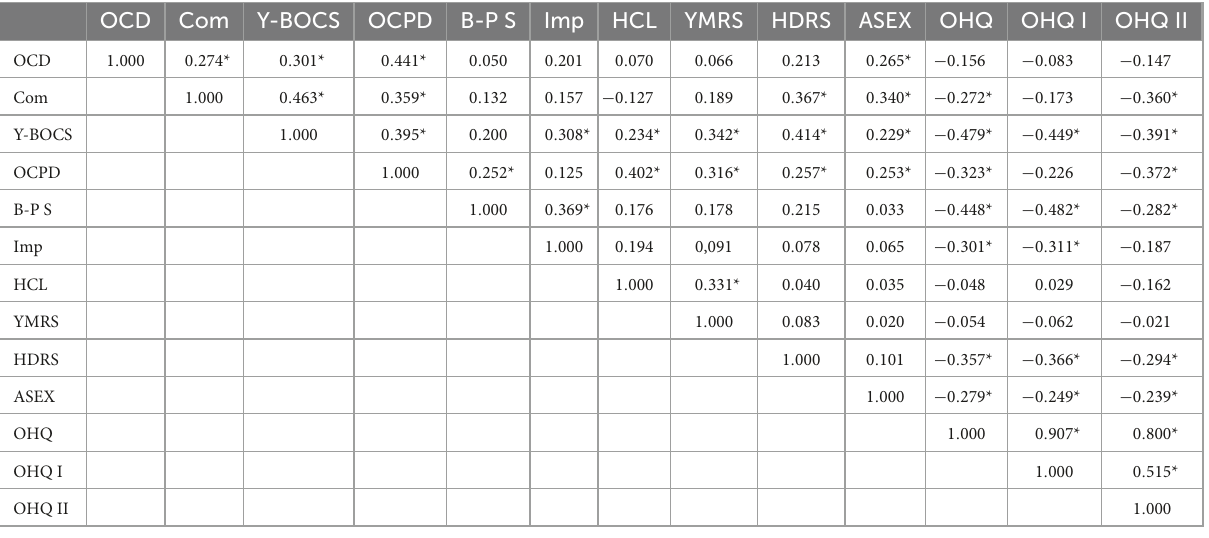
TABLE 3 Correlations between happiness and selected psychopathological phenomena in the obsessive-compulsive disorder (OCD) group. OCD Com Y-BOCS OCPD B-P S Imp HCL YMRS HDRS ASEX OHQ OHQ